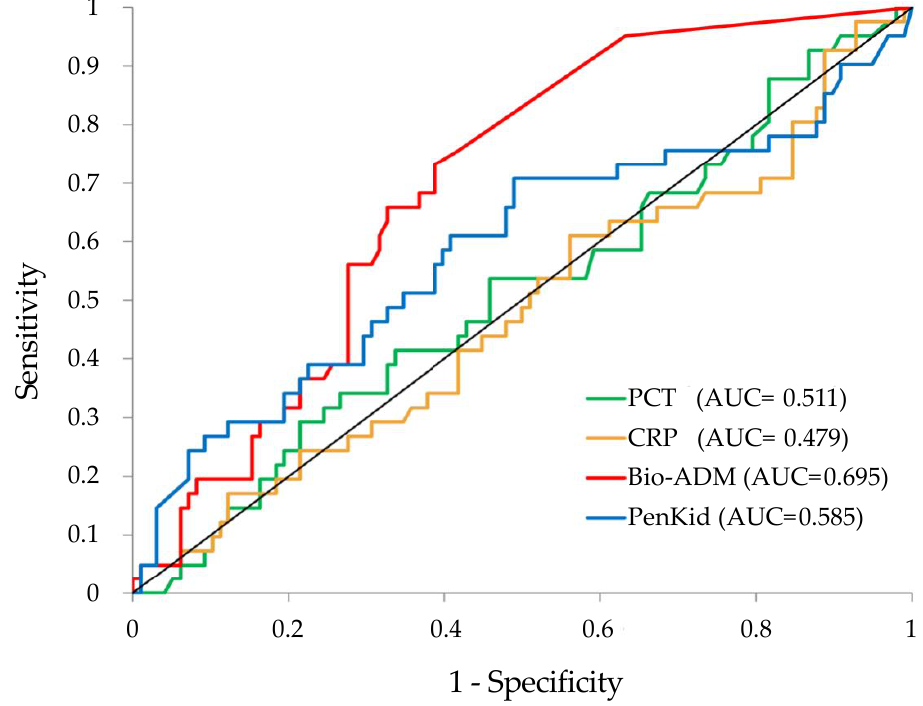
Figure 3. ROC curves for biomarkers. Bio-ADM: Bio-adrenomedullin, red line; PenKid: proenkephalin A, blue line; PCT: procalcitonin, green line; CRP: C reactive protein, yellow line.